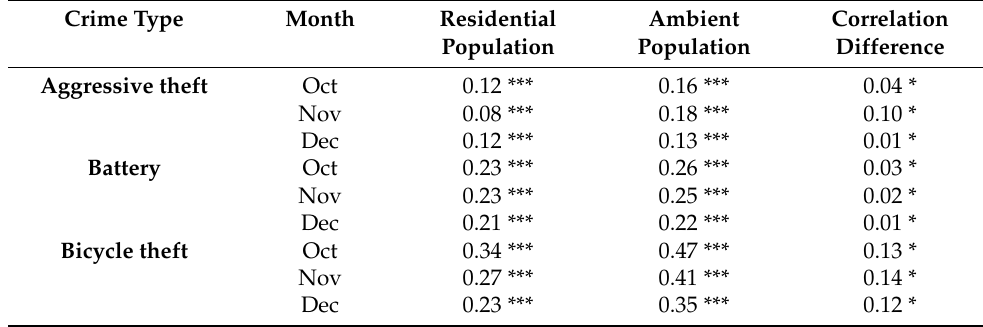
Table 3. Point-biserial correlation coefficients of crime vs. residential and ambient population (grid level, N = 4206).